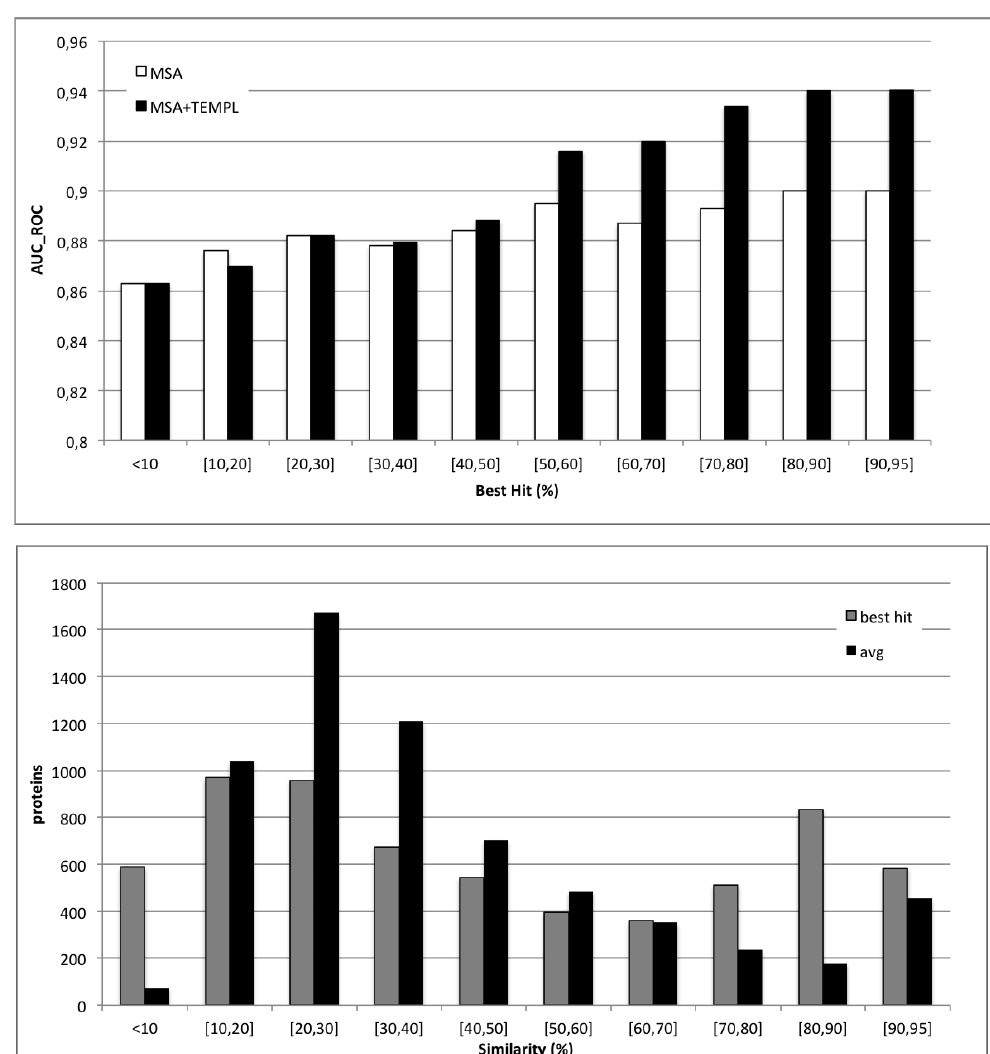
Figure 4. Distribution of the area under the ROC curve as a function of sequence identity of the examples to the best template that could be found. Black bars represent template-based results (MSA-Templ) and white bars sequence-based results (MSA) ( top ); The number of proteins with templates within given ranges of sequence identity. Black bins represent average sequence identity; grey bins identity to the best template ( bottom